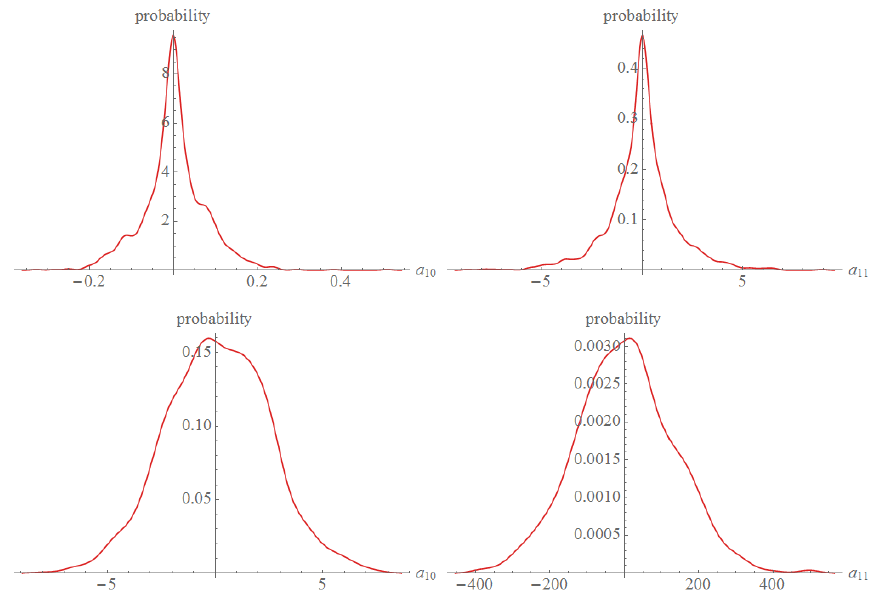
Figure 3 . The probability distribution of the Taylor series coe(cid:14)cients a 10 and a 11 for neural network in two dimension. We consider the sigmoid activation (upper) and the sine activation (lower) respectively. The data is constructed via x 0 = y 0 = 1, (cid:11) = 100, (cid:12) = 100, w = 1 =h and h = 100, and we realize the network for 1000